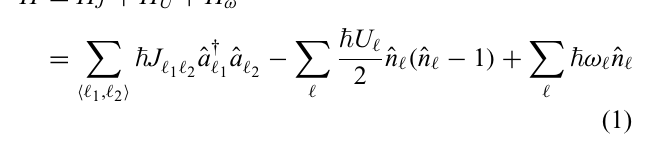
when written in the basis of local bosonic annihilation ˆ a † ˆ n = ˆ a † ˆ a ˆ a (cid:3) , creation (cid:3) (cid:3) , and occupation number (cid:3) (cid:3) opera- ˆ tors. Here, allows the excitations to move from one H J ˆ lattice site to a neighboring one, takes into account H U local attractive interactions between the excitations, and ˆ H ω represents the potential energy landscape provided to the excitations by the transmon array. Typically [16, 20,21], the on-site energy ω (cid:3) / 2 π ∼ 5 GHz, the interac- tion strength U (cid:3) / 2 π ∼ 200 MHz, and the hopping rate / 2 π ∼ 10 MHz. The parameters of the model there- J (cid:3) (cid:3) 1 2 (cid:2) is (cid:5) U (cid:5) ω fore satisfy the hierarchy J (cid:3) (cid:3) (cid:3) (cid:3) . Finally, 1 2 the reduced Planck